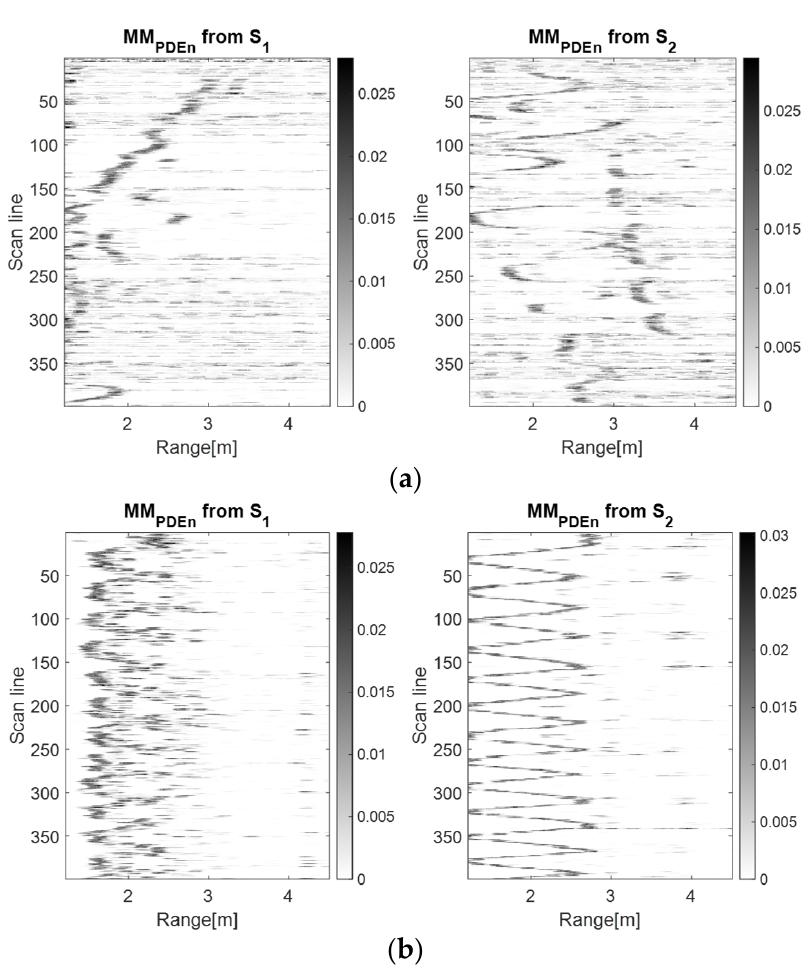
Figure 10. The drone ( a ) and the human ( b ) left–right movement maps using the PDEn method with m = 5, d = 1, σ = 0.71.